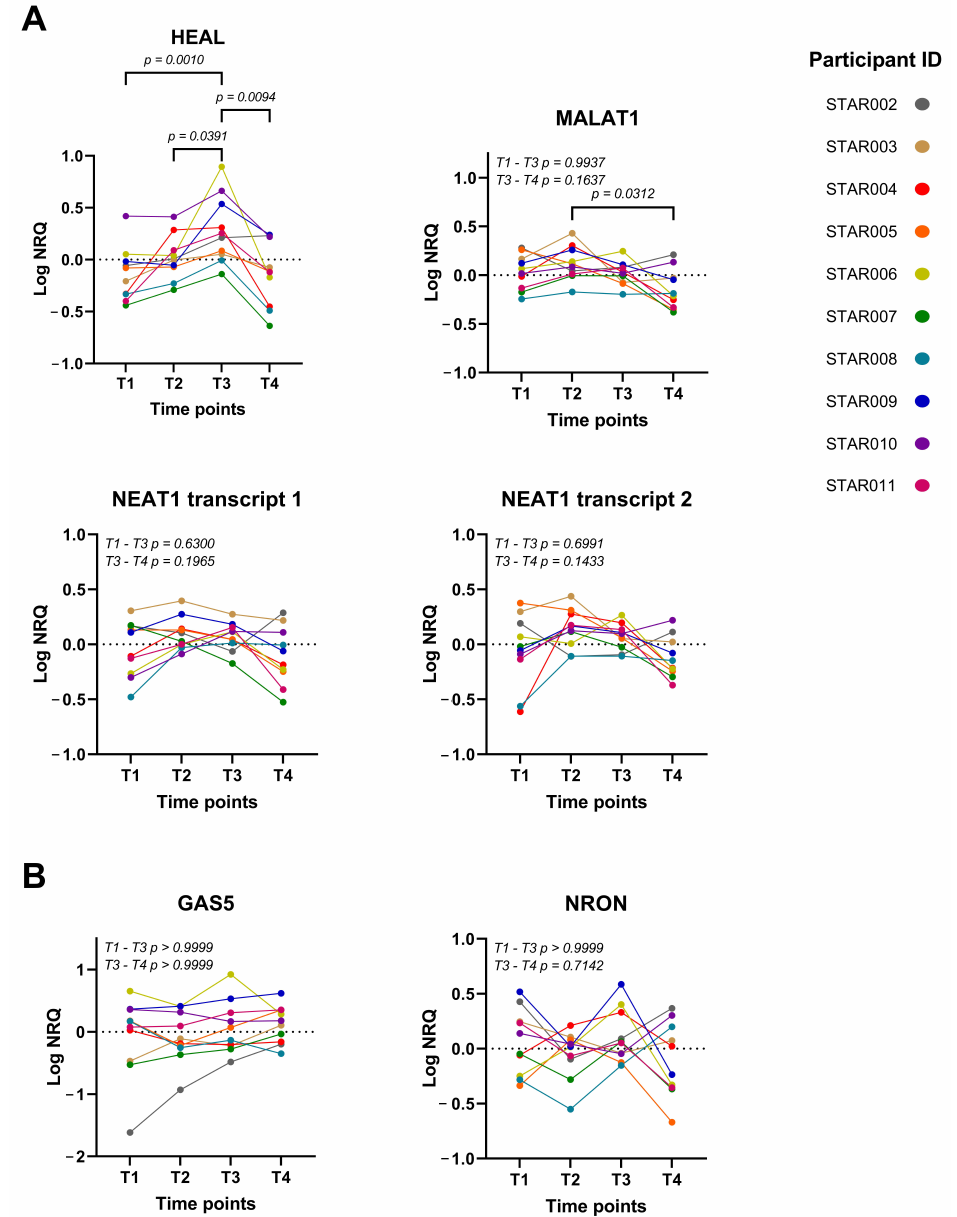
Figure 2. Expression of lncRNAs during ATI in 10 patients on long-term ART. Expression levels of the lncRNAs were quantified with RT-qPCR and normalized using 3 reference genes. Normalized relative quantities are shown at four timepoints (T1–T4) for lncRNAs that are ( A ) up- or ( B ) downregulated upon HIV-1 infection according to the literature. Normal distribution of the data was assessed using a D’Agostino–Pearson test. For normal distributed data, a one-way ANOVA with a post hoc Tukey’s Honest Significant Difference test was performed. For non-normal distributed data, a Friedman test with a Dunn’s post hoc test was performed. Significant p -values are indicated with brakes. NRQ, normalized relative